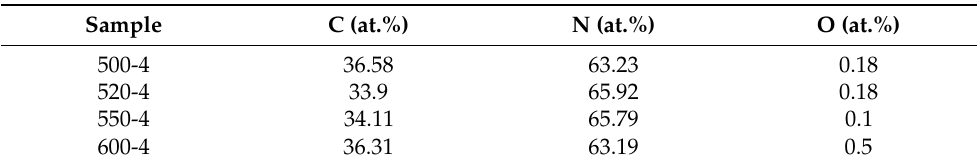
Table 2. C, N, O atomic concentration of polymeric carbon nitride (PCN) synthesized at 500, 520, 550, and 600 ◦ C.